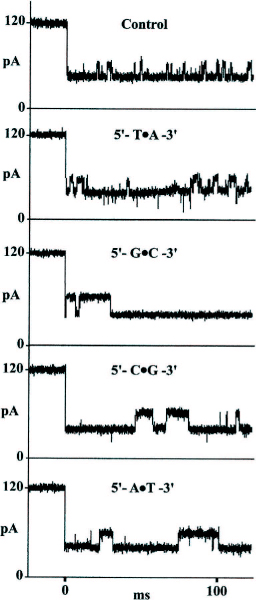
Typical blockade signatures for each of the five classes of DNA hairpins. Source [6]